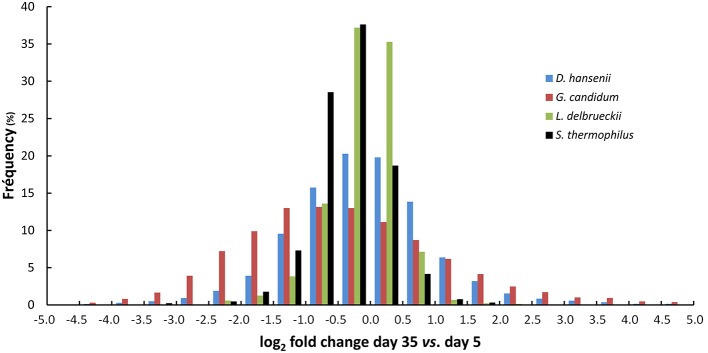
Stability of the transcriptomes of G. candidum, D. hansenii, L. delbrueckii, and S. thermophilus during cheese ripening. The diagram shows the distribution of the fold changes for the CDSs, expressed as log2 of fold change between day 5 and 35.